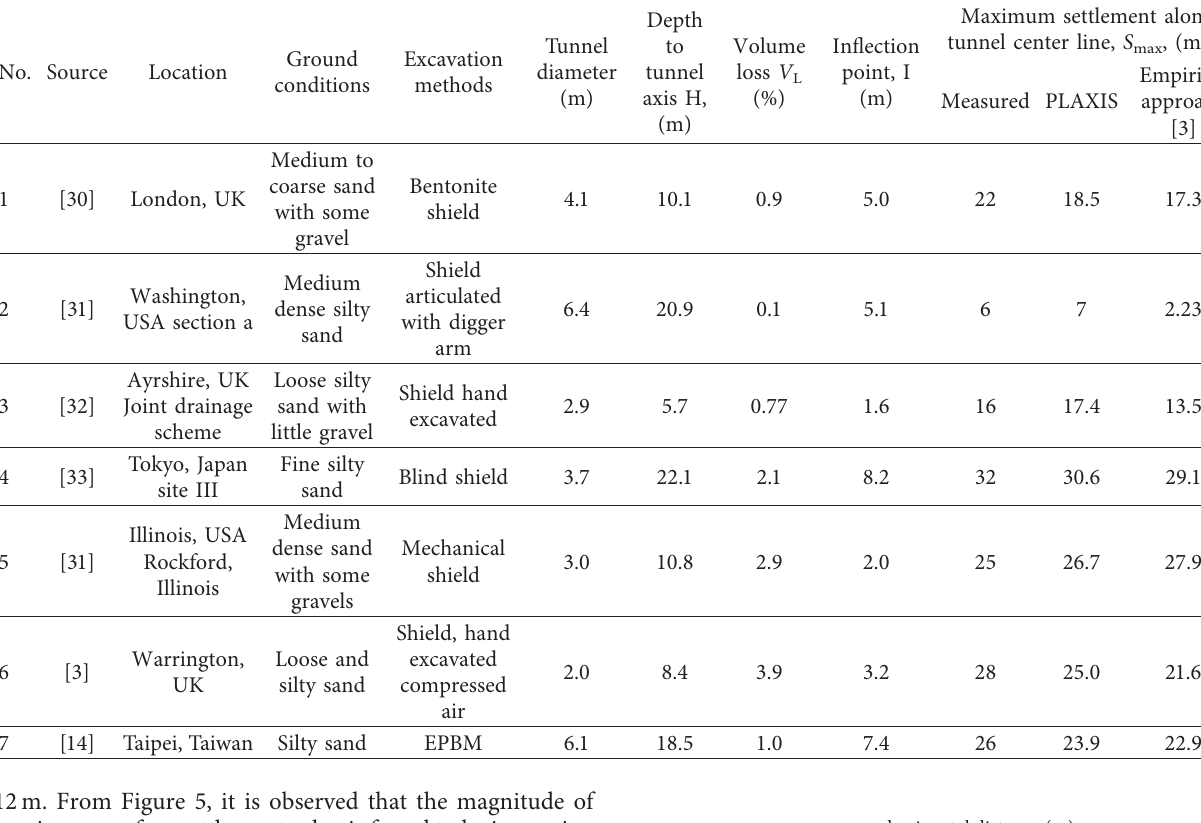
Table 3: Details of tunnels in sands and maximum surface settlement, s